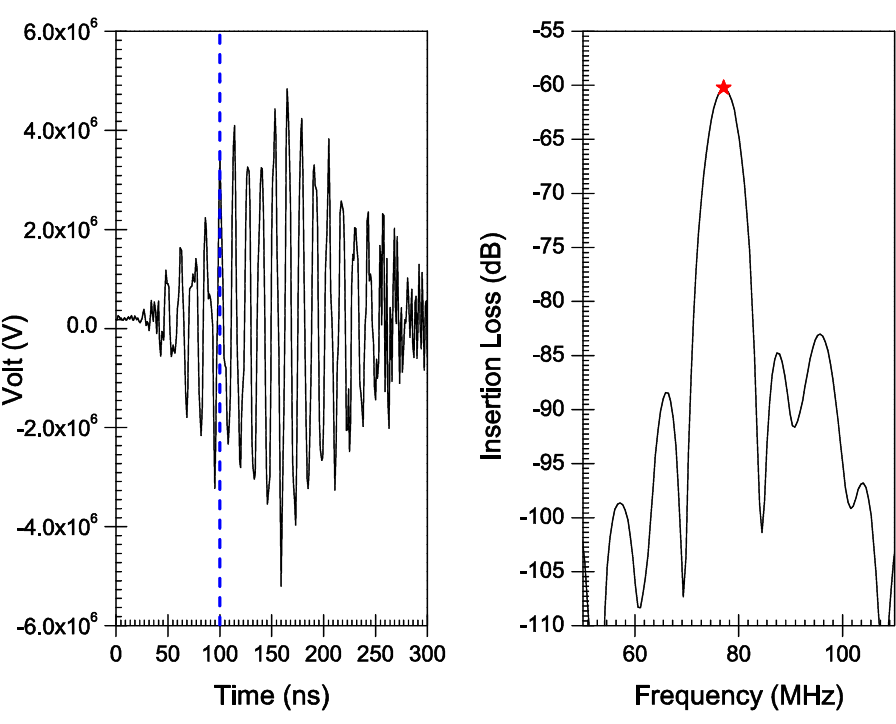
Figure 10. Time and frequency response for h /λ = 0.1.